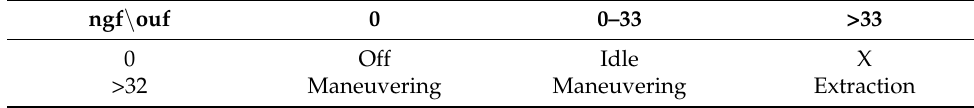
Table 3. Assignment of operating states to observed current intensities.